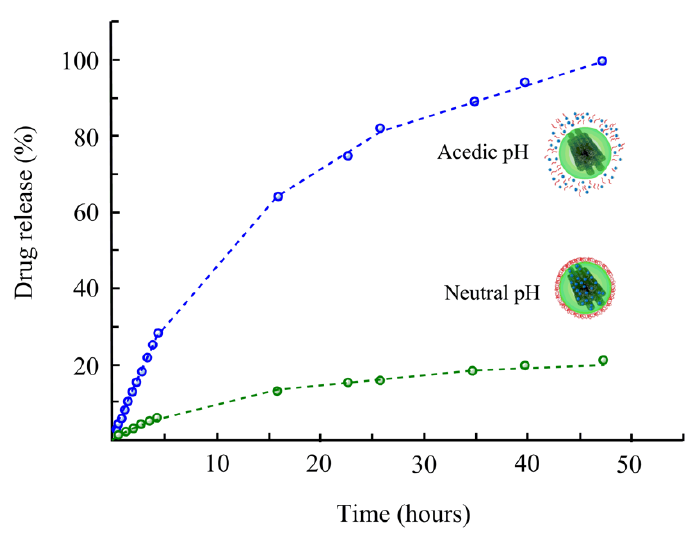
Figure 6. Schematic diagram of the pH-responsive mesoporous carbons. At physiological pH, the self-immolative coating remains collapsed on the surface. Conversely, at acidic pH, the polymers undergo self-immolation, leading to cargo release. Adapted with permission from